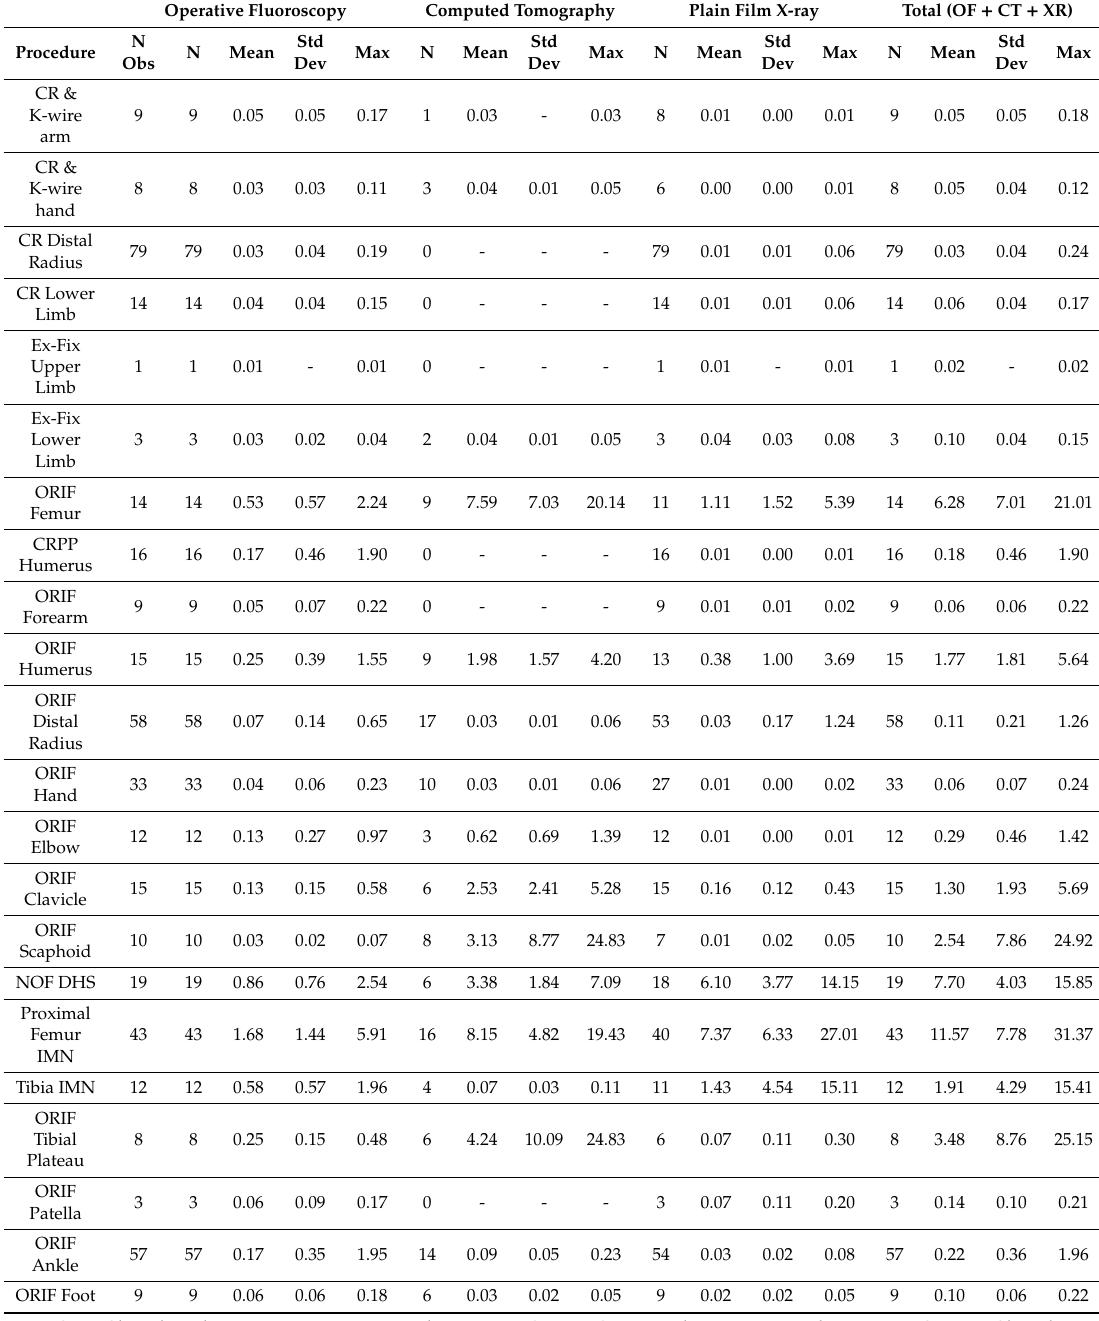
Table 4. Dose by